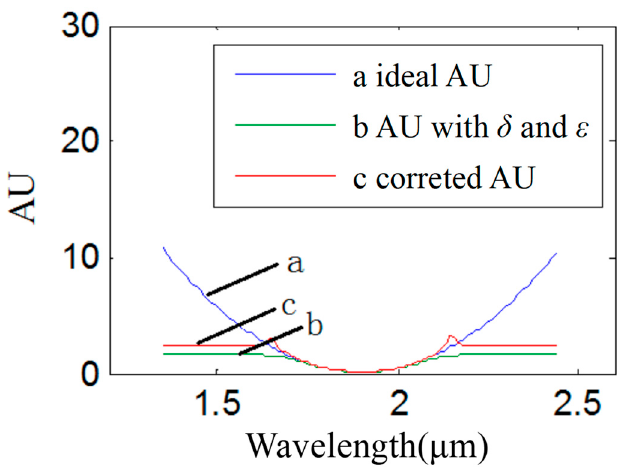
the noise of two types of stray light, including variable stray light and intrinsic stray light.